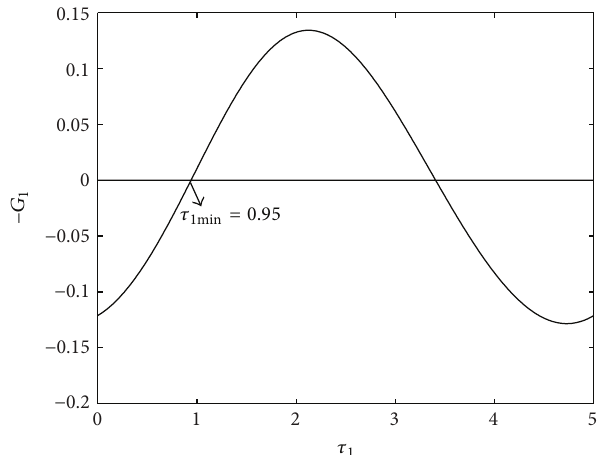
Figure 1: Illustration of the existence of the minimal value point. The parameter values are fixed as follows: 𝑟(𝑡) = 1.5+0.3 cos (0.4𝜋𝑡) , 𝑏(𝑡) = 1 + 0.2 sin (0.4𝜋𝑡) , 𝛿(𝑡) = 0.5 + 0.1 cos (0.4𝜋𝑡) , 𝜎 = 0.25 𝑝 1